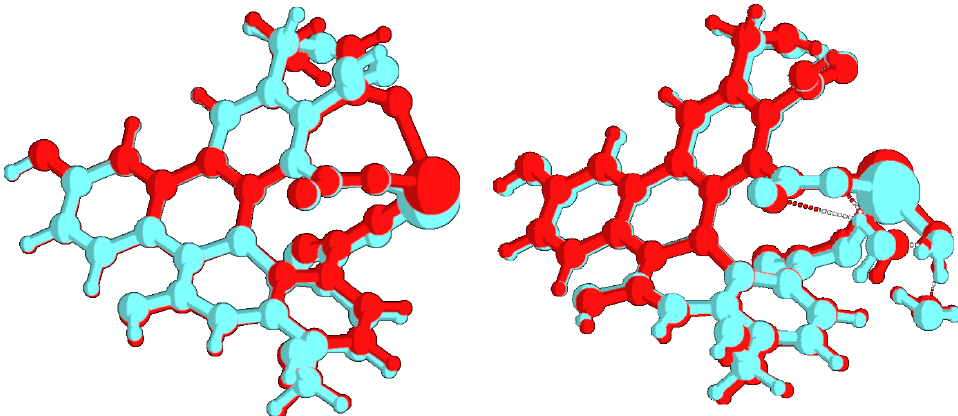
Figure 8. Overlay of UFQD-Cd/UFQD-Pb ( left panel ) and of UFQD-CdW/UFQD-PbW structures ( right panel ). Pb: red; Cd: cyan.